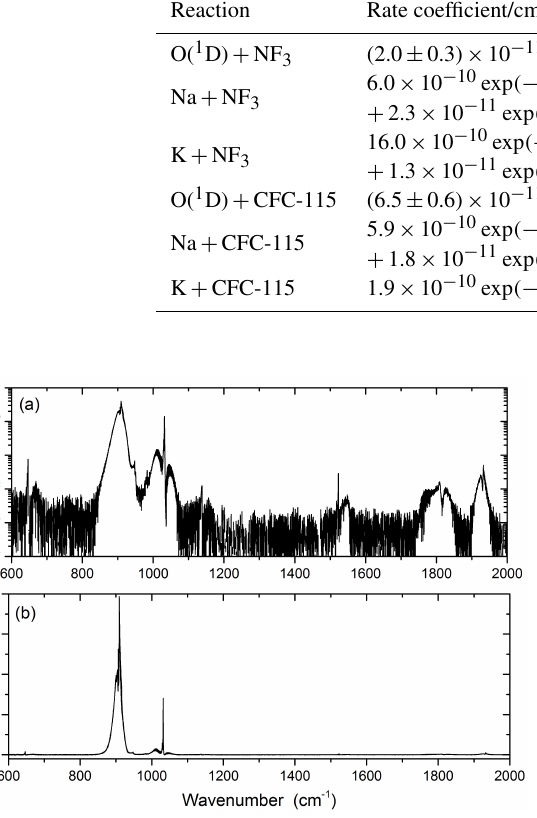
Figure 1. Infrared absorption spectrum of NF 3 at 295 ± 2K on a logarithmic (a) and linear (b) scale. The logarithmic plot highlights the minor